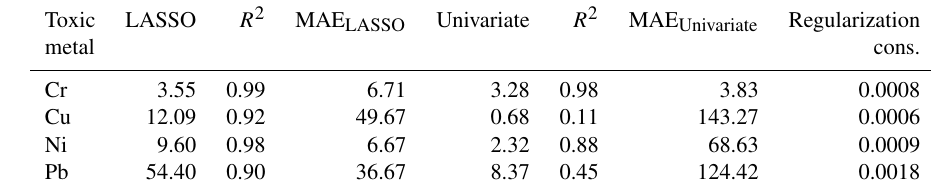
Table 3. Detection limits for various toxic metals based on the LASSO and univariate models.